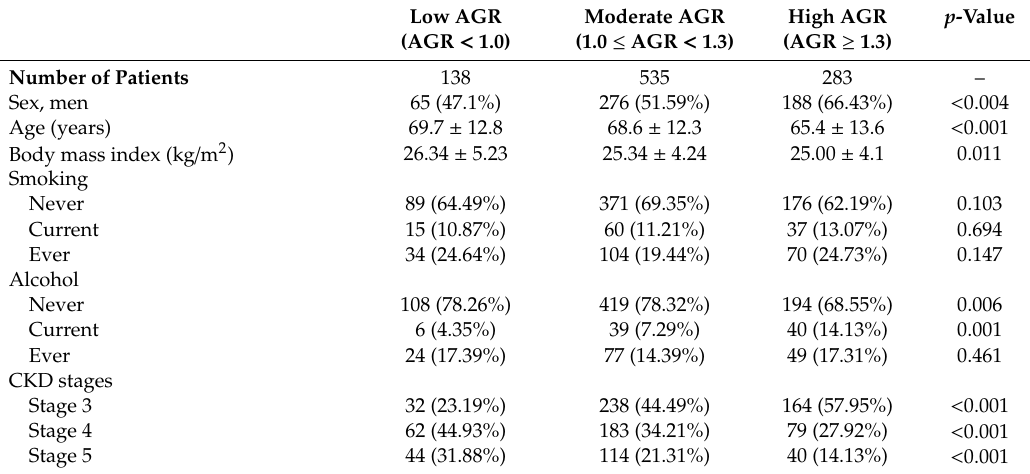
Table 1. Baseline characteristics of the study population by the AGR